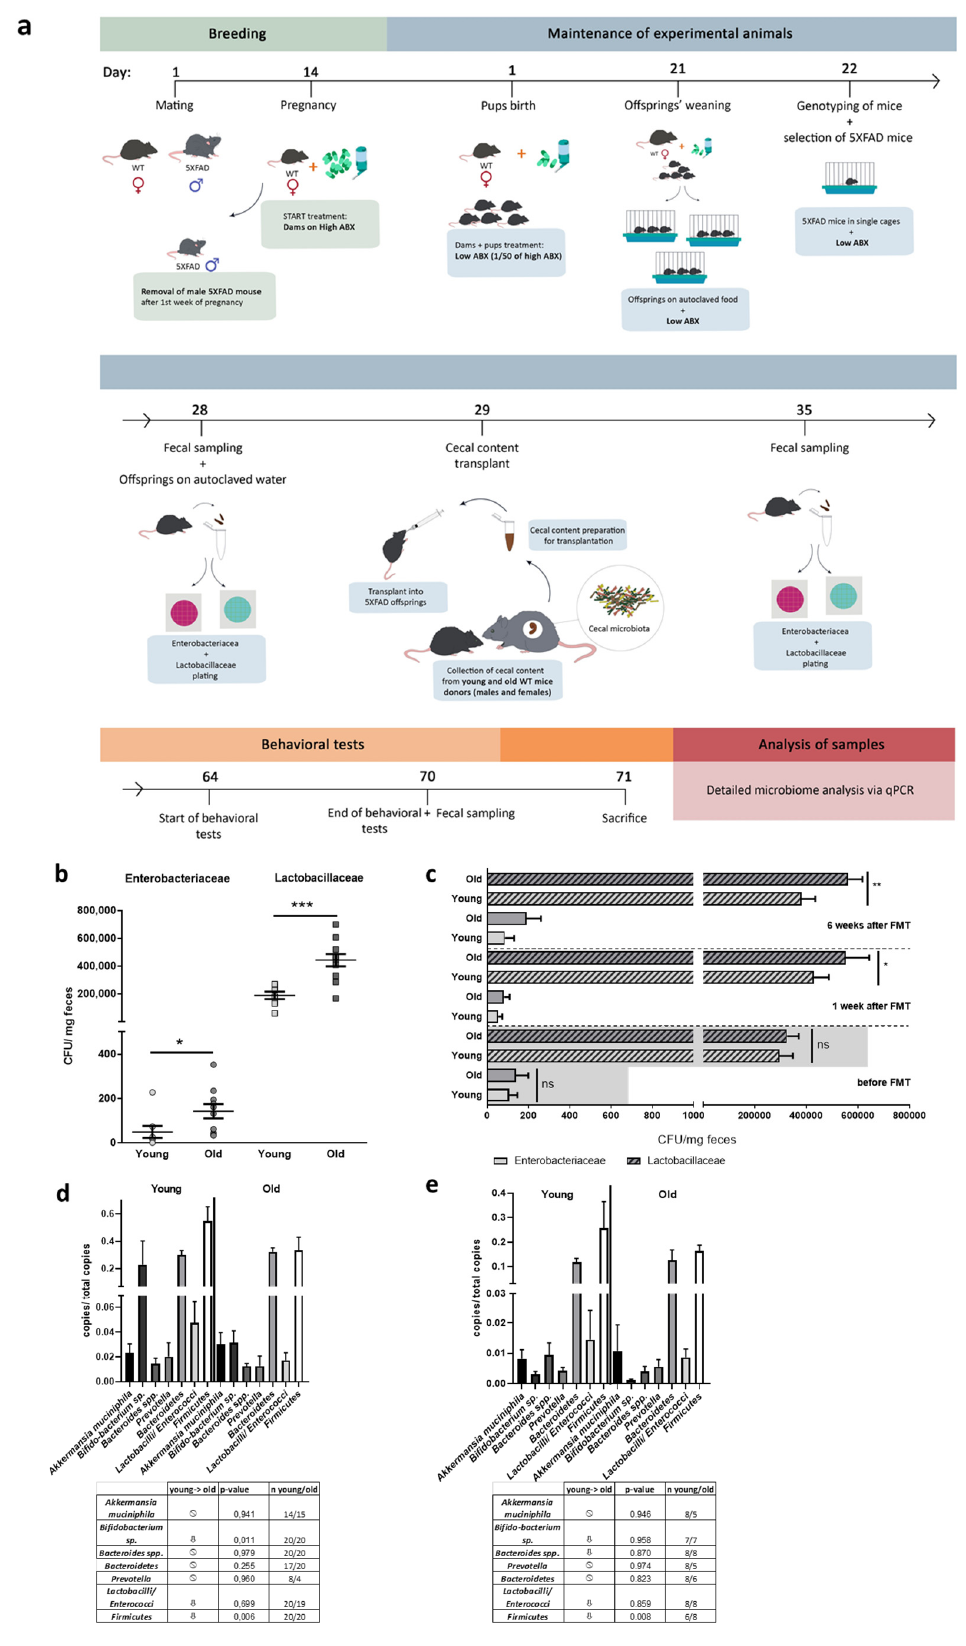
Figure 1. FMT after pre- and postnatal antibiotics treatment of 5xFAD model mice. ( a ) Dams were subjected to antibiotics (ABX) treatment via drinking water after two weeks of pregnancy (high ABX). With giving birth, antibiotics dosage was